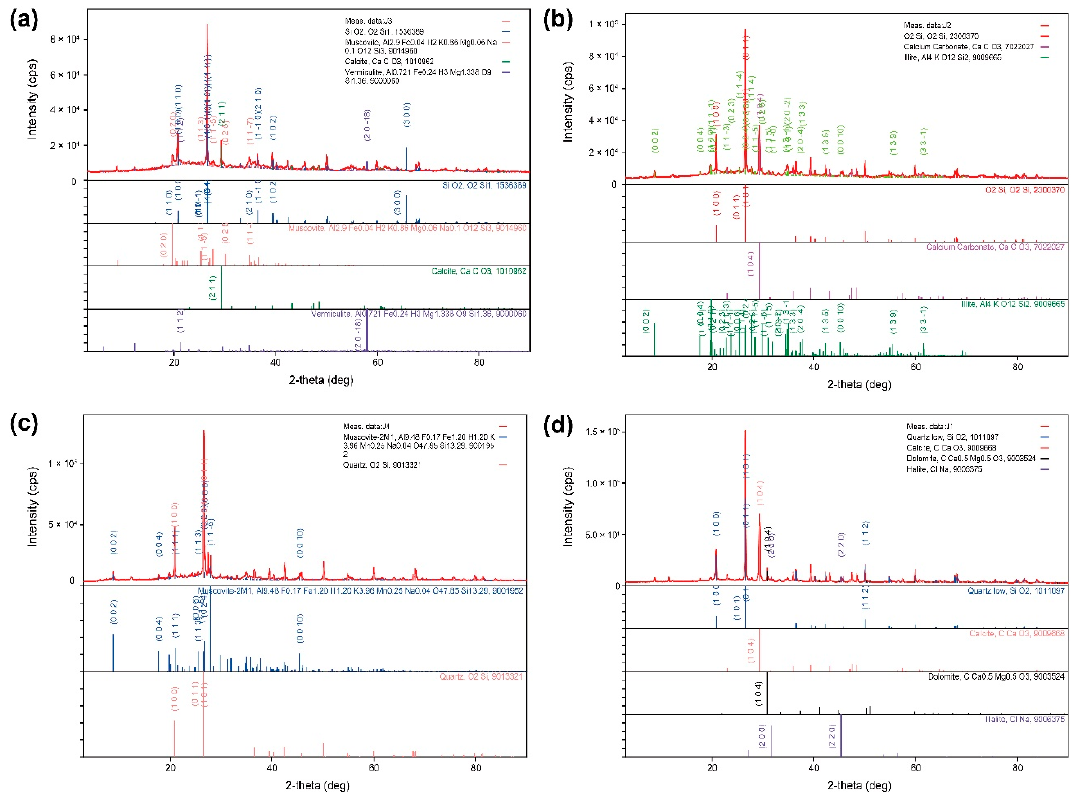
Figure 10. Results of X-ray diffraction (XRD) analysis of matter precipitated by water sample Figure10. ResultsofX-raydi ff raction(XRD)analysisofmatterprecipitatedbywatersampleevaporation evaporation at ( a ) HMS1, ( b ) KGS1-1, ( c ) KGS5, and ( d ) SJS1. at ( a ) HMS1, ( b ) KGS1-1, ( c ) KGS5, and ( d )